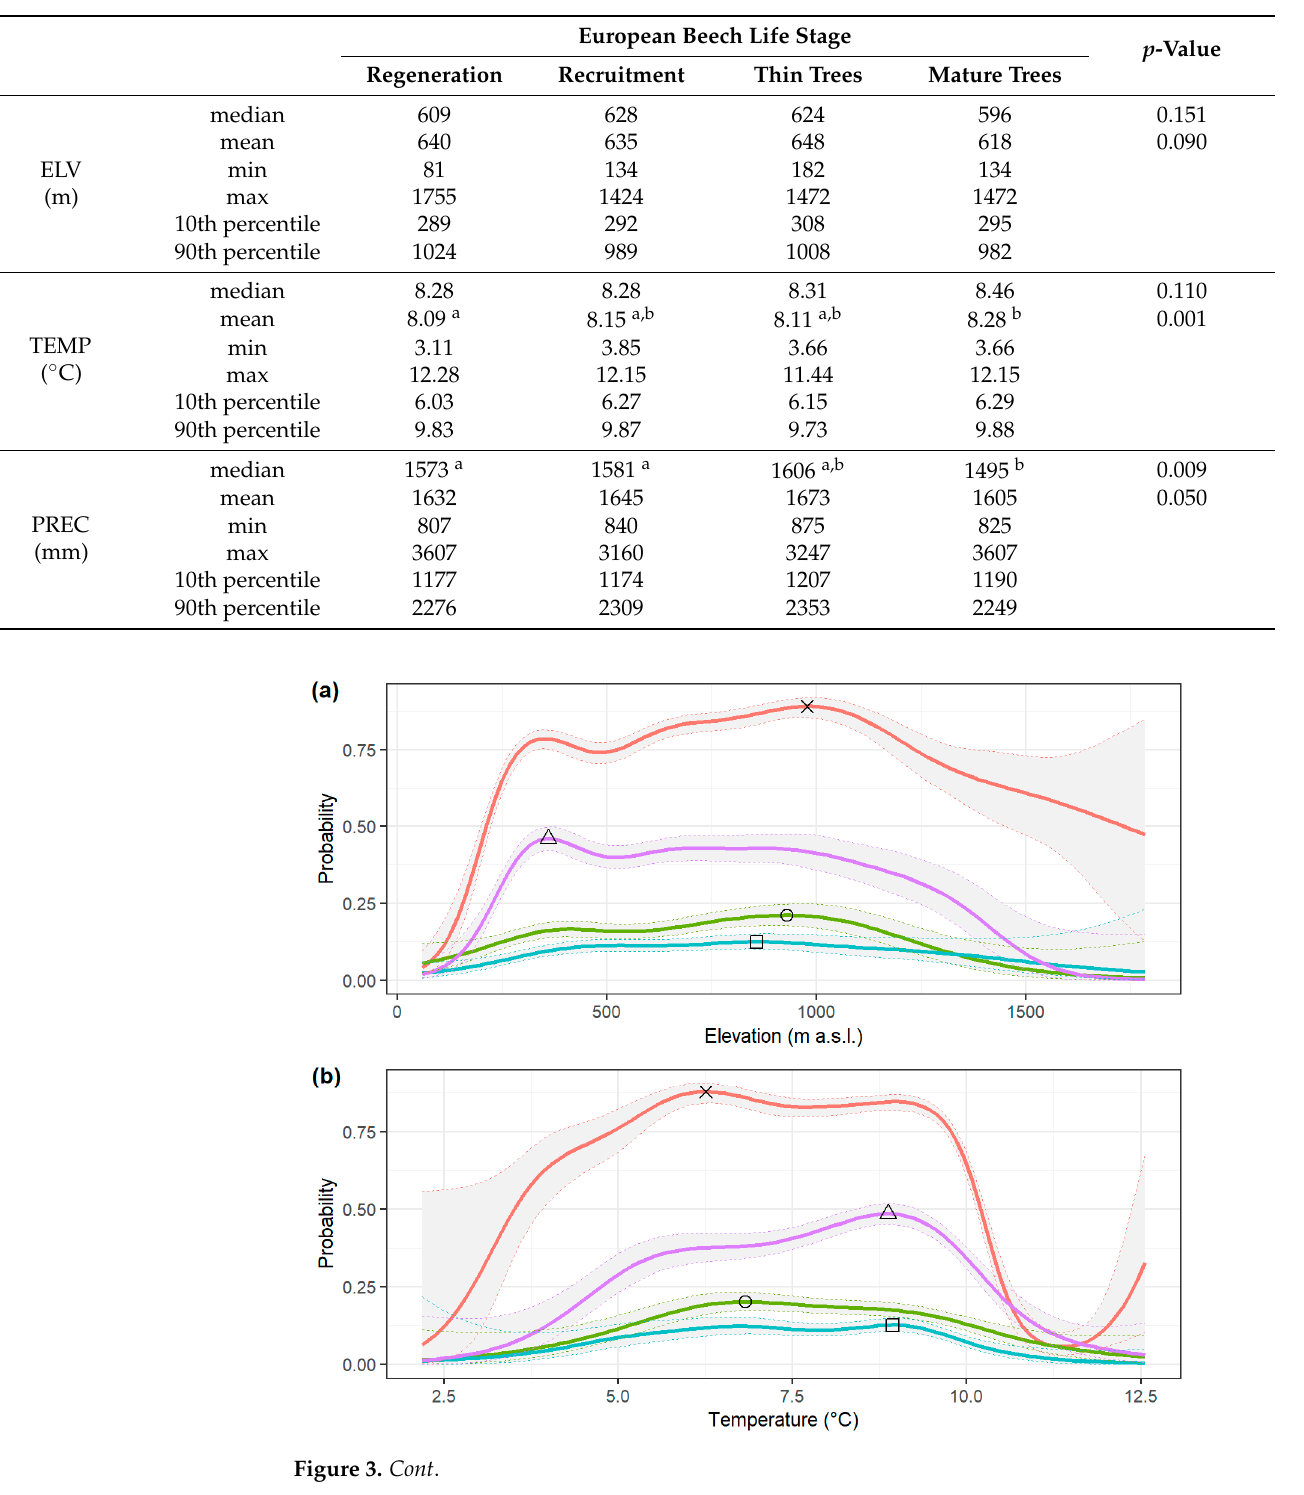
Table 1. Characteristic values of European beech life stage presence distributions along elevation (ELV), long-term mean annual temperature (TEMP) and long-term mean annual precipitation (PREC) gradients; p -values indicate the significance in median (Mood’s median test) and means (ANOVA), respectively; superscript letters indicate group membership according to post hoc median pairwise comparisons or Tukey’s HSD test.